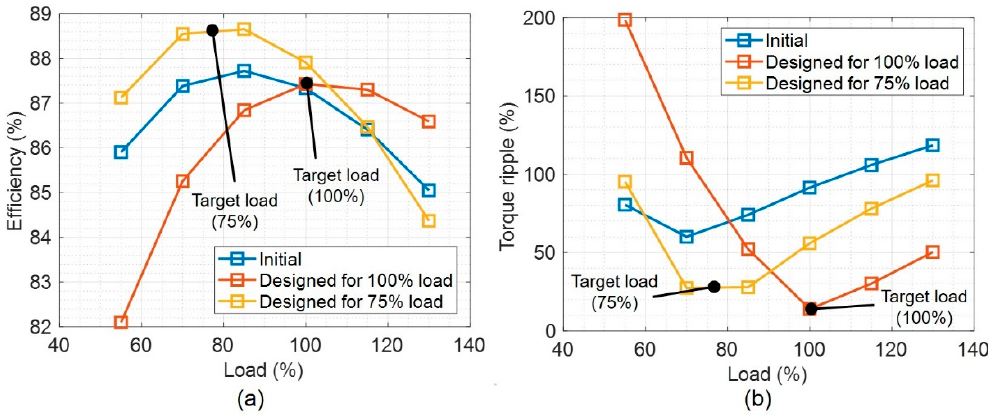
Figure 7. ( a ) The efficiency and ( b ) torque ripple of initial and two designed model at different loads.